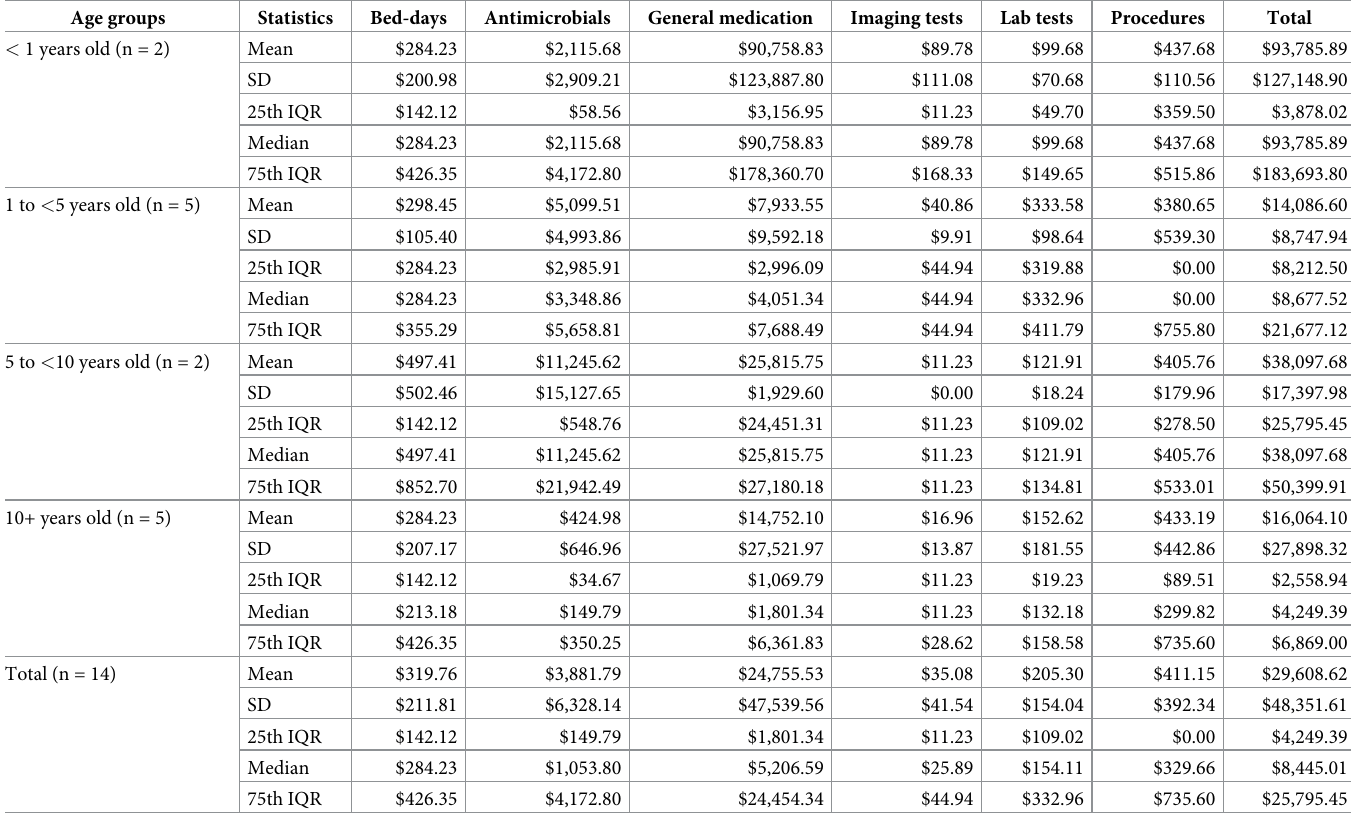
Table 4. Direct costs for patients treated for in the intensive care unit